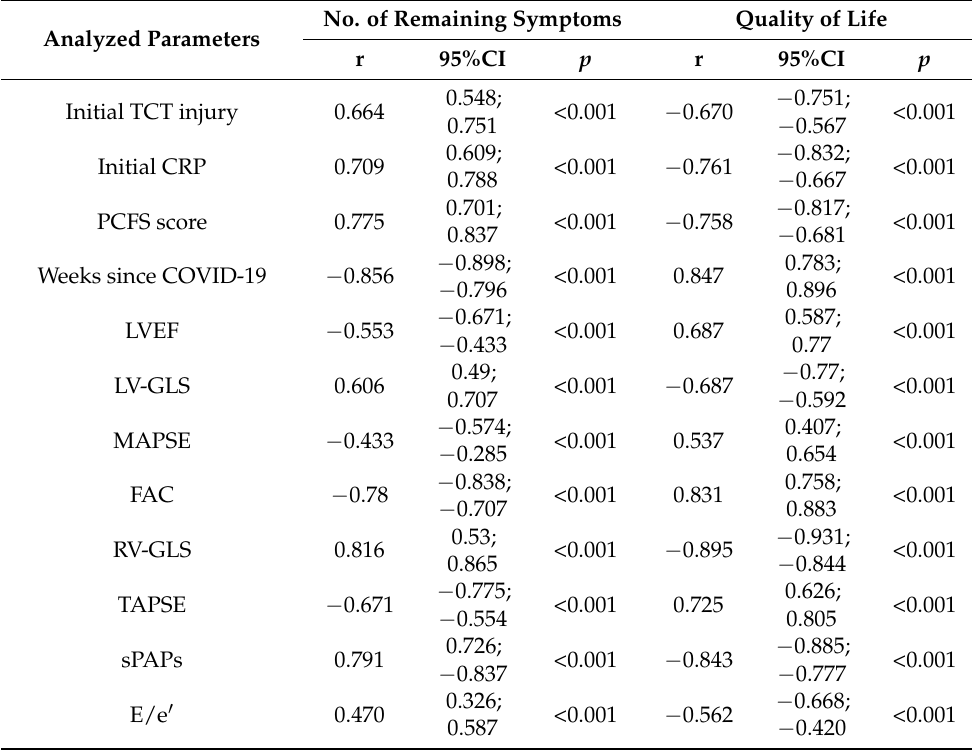
Table 2. Correlations between number of symptoms and EQ-5D-5L QoL scores. Analyzed